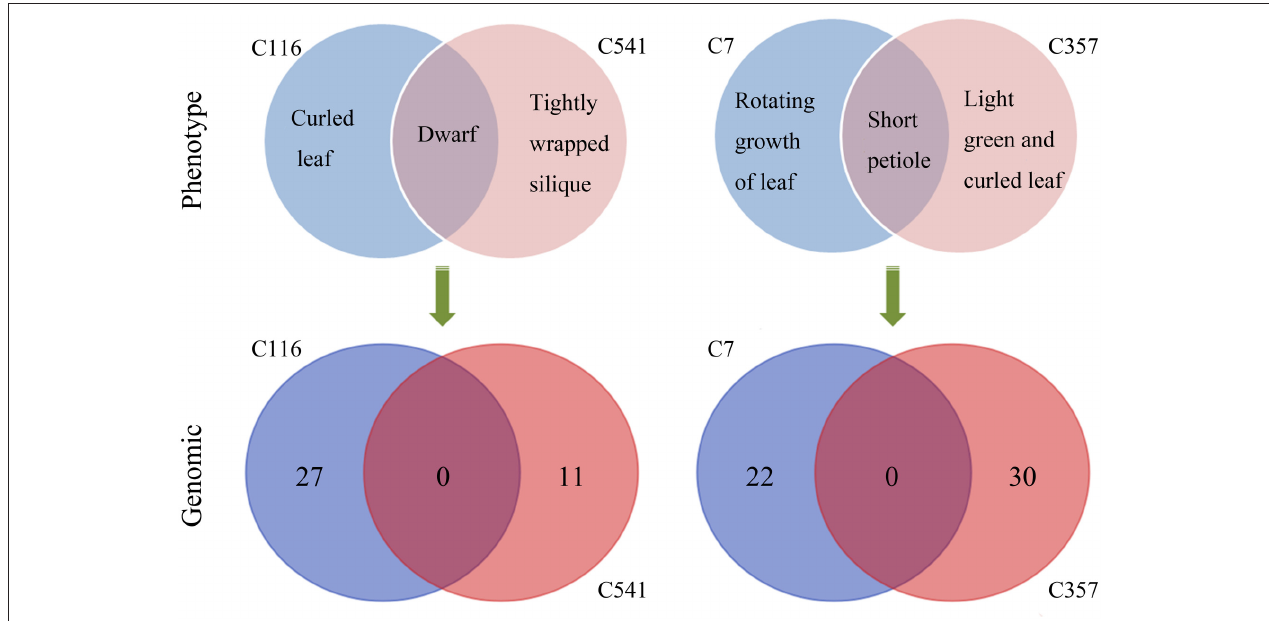
FIGURE 7 | Similarity between the mutant lines with similar phenotypes at the genomic level. The homozygous mutations in M3 were used to detect whether there were any common mutations at the genomic level between the re-sequenced lines sharing similar phenotypes.